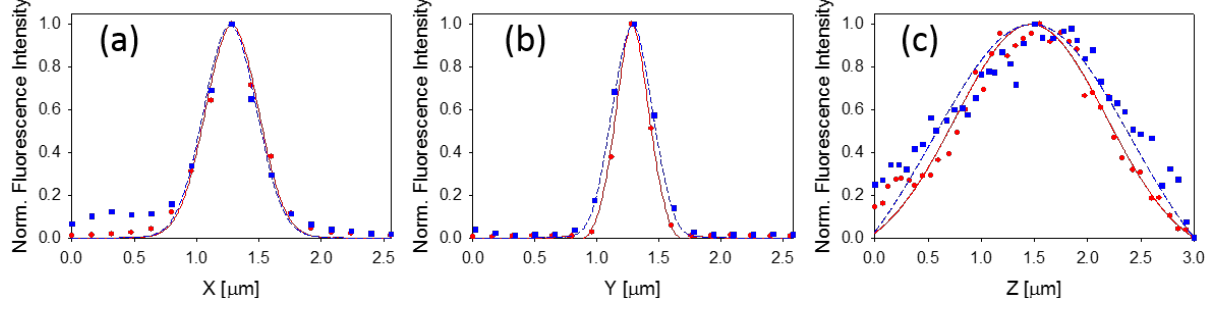
Figure 2. Point spread function (PSF) cross-sections along ( a ) x ; ( b ) y ; and ( c ) z axes as measured by the line-scan excitation (red circles) and the point-scan excitation (blue squares). The solid (red) and dashed (blue) lines represent Gaussian fits for the line-scan-and point-scan data, respectively. The resulting FWHM for x -PSF is 0.5 μm for both point-scan and line-scan. The resulting FWHM for y -PSF is 0.3 μm for line-scan and 0.37 μm for the point-scan. Finally, the resulting FWHM for z -PSF is 1.6 μm for line-scan and 2.0 μm for the